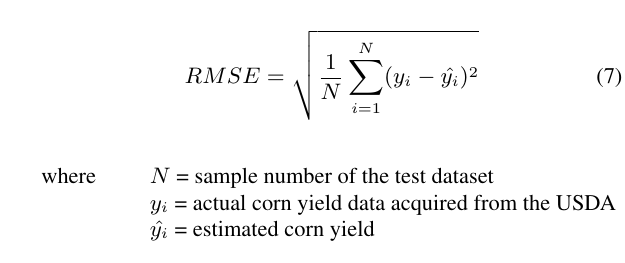
Figure 7: Diagram of the deep neural network used in this study